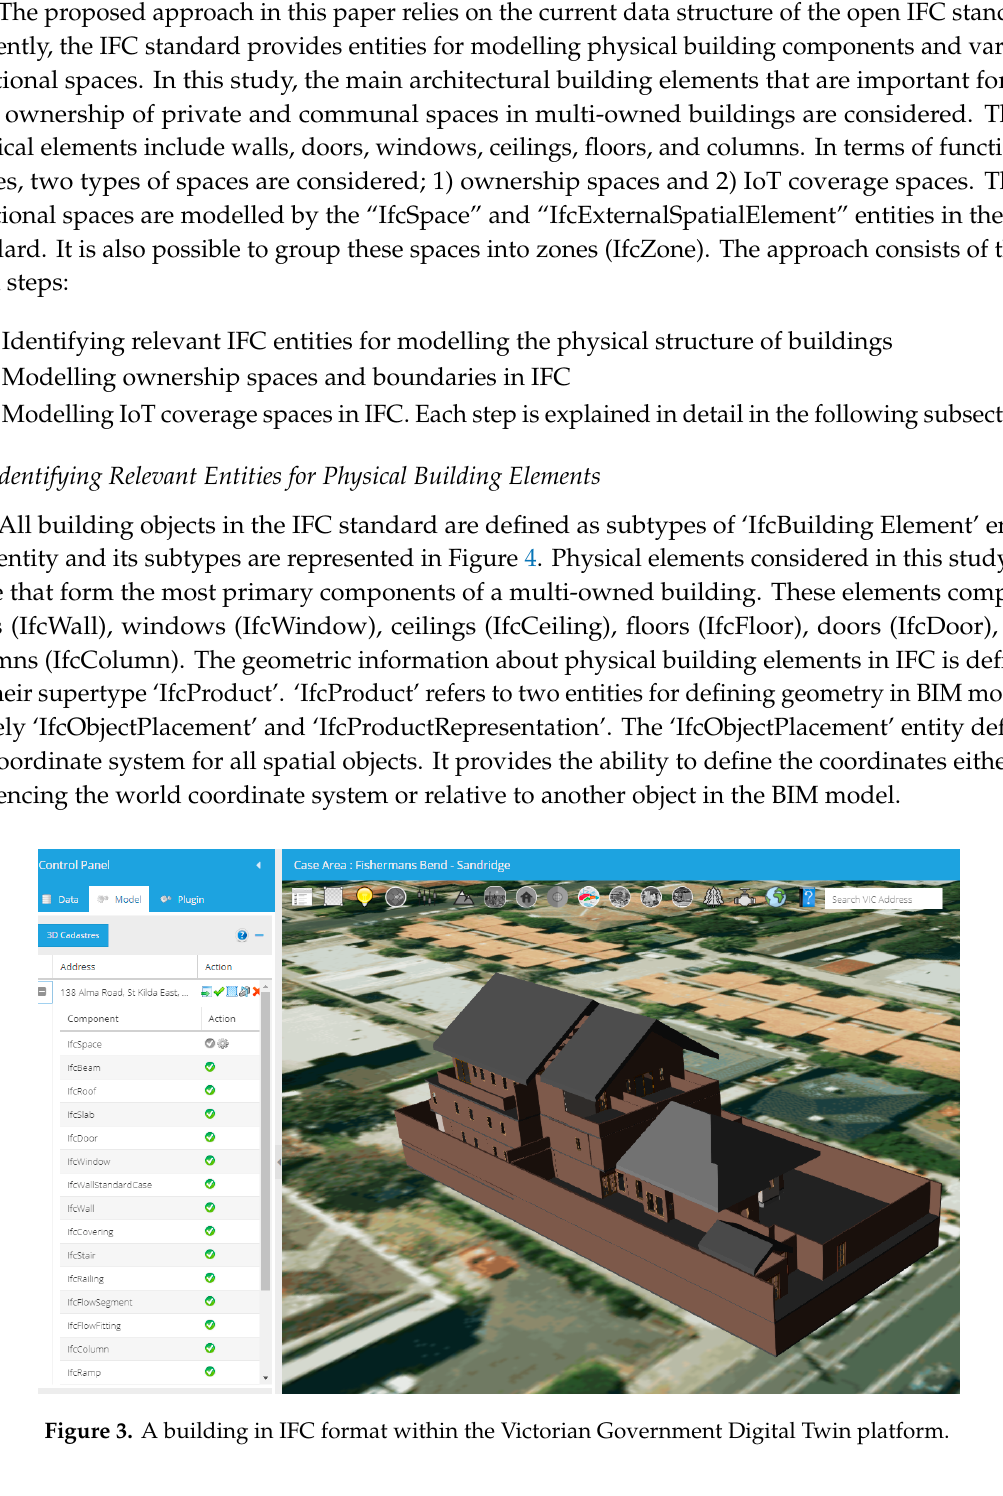
Figure 5. Geometric modelling of ownership boundaries in IFC.